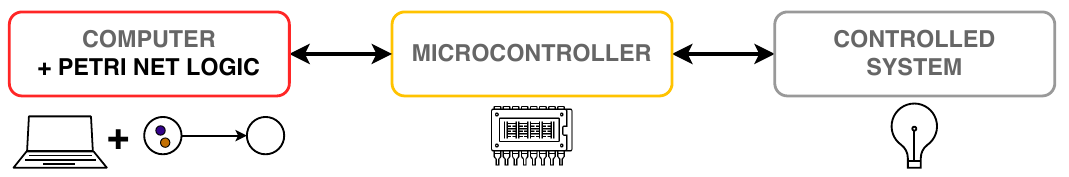
Figure 2. Basic scheme of proposed solution—Petri net’s logic in personal computer